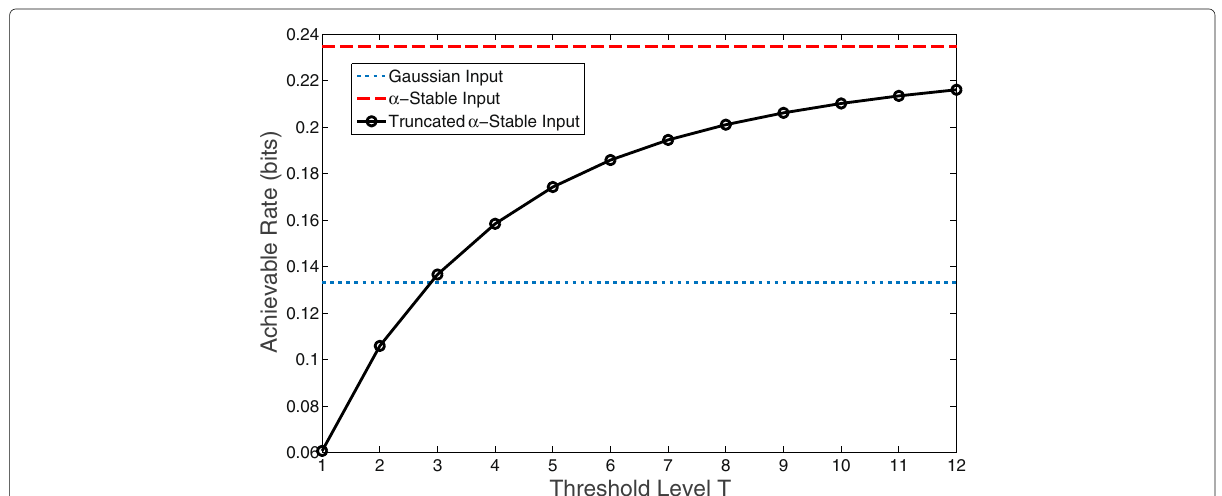
Fig. 5 Achievable rates for an AI α SN channel with α = 1.3, σ N = 0.5 and a constraint E [ | X | ] ≤ 1. The curves correspond to a Gaussian input, an isotropic α -stable input and a truncated isotropic α -stable input (defined in